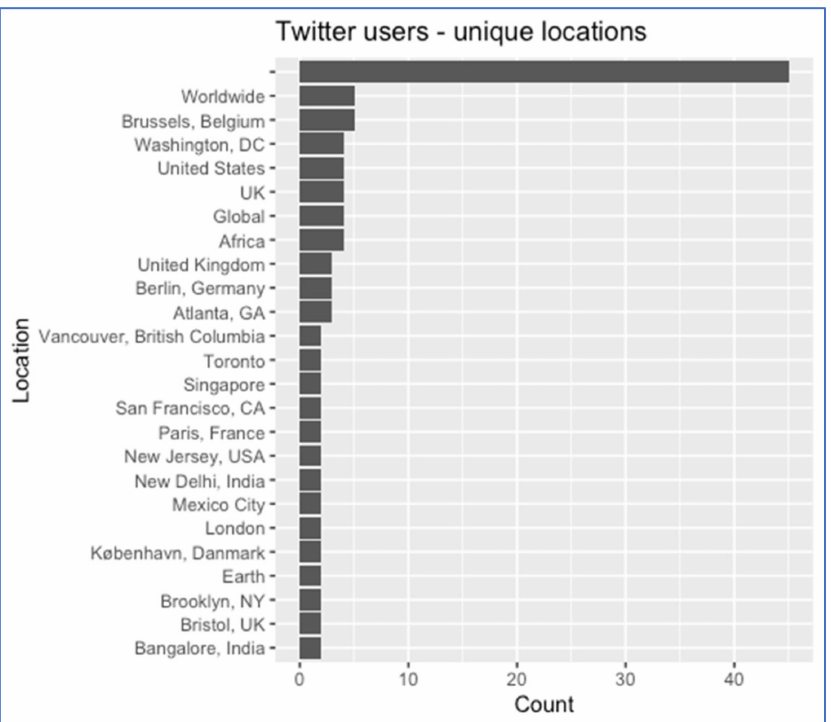
Figure 5. Twitter users—unique